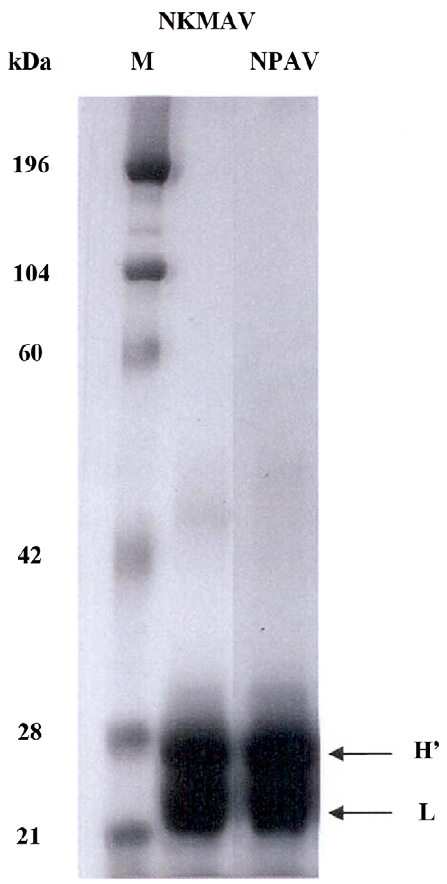
Figure 1. SDS-PAGE of Neuro Polyvalent Snake Antivenom (NPAV) and Naja kaouthia monovalent antivenom (NKMAV). Fifteen m L of the respective reconstituted antivenom (3 mg/ml) was loaded on the middle (NPAV) and right lane (NKMAV). Prestained molecular weight markers mixture was loaded on the left lane (M, molecular weight in kDa). The digested heavy chain (H 9 ) and light chains (L) are indicated by black arrowheads.